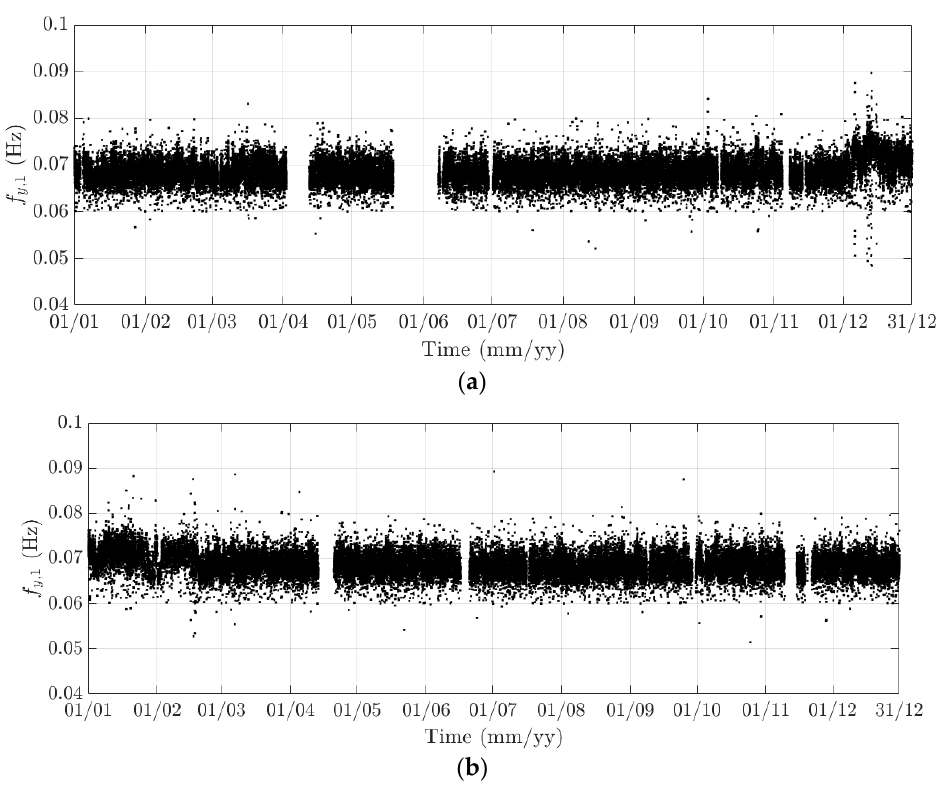
Figure 18. Variation of the 10 ‐ min natural frequency of the first lateral model in ( a ) 2015 and ( b ) 2016.